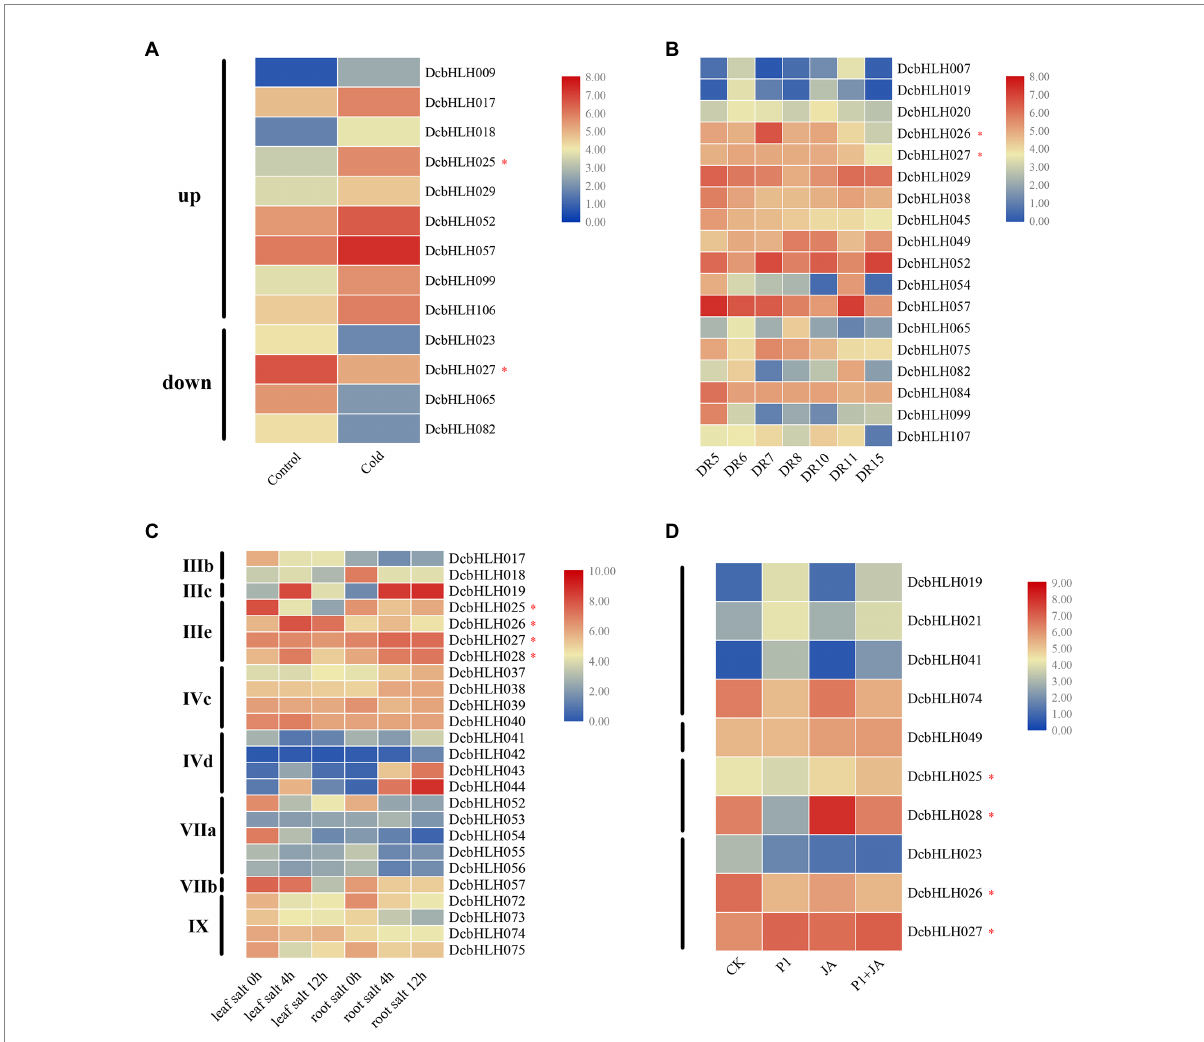
FIGURE 4 Relative expression analysis of the DcbHLH genes under different stress conditions. (A) Low-temperature treatment (CK: 20 ° C, 20 h; Cold: 0 ° C, 20 h). (B) Drought treatment [Drought stage: DR5/DR6 (the next day 06:30 and 18:30 h), Dr7/DR8 (06:30 and 18:30 h on the seventh day)]; Rehydration stage: DR10 (18:30 h on the eighth day), and DR11/DR15 (06:30 and 18:30 h on the ninth day). (C) Salt stress treatment. Leaf salt 0/4/12 h: Leaf treated with 250 mM NaCl for 0/4/12 h. Root salt 0/4/12 h: Root treated with 250 mM NaCl for 0/4/12 h. (D) Expression profiles of DcbHLH genes to S. delphinii after pre-treatment with MeJA (CK: control. P1: 24 h after post-inoculation with S. delphinii . JA: pre-treated with MeJA for 4 h and then inoculated with sterile distilled water for 24 h. P1 + JA: pre-treated with MeJA for 4 h and then inoculated with S. delphinii for 24